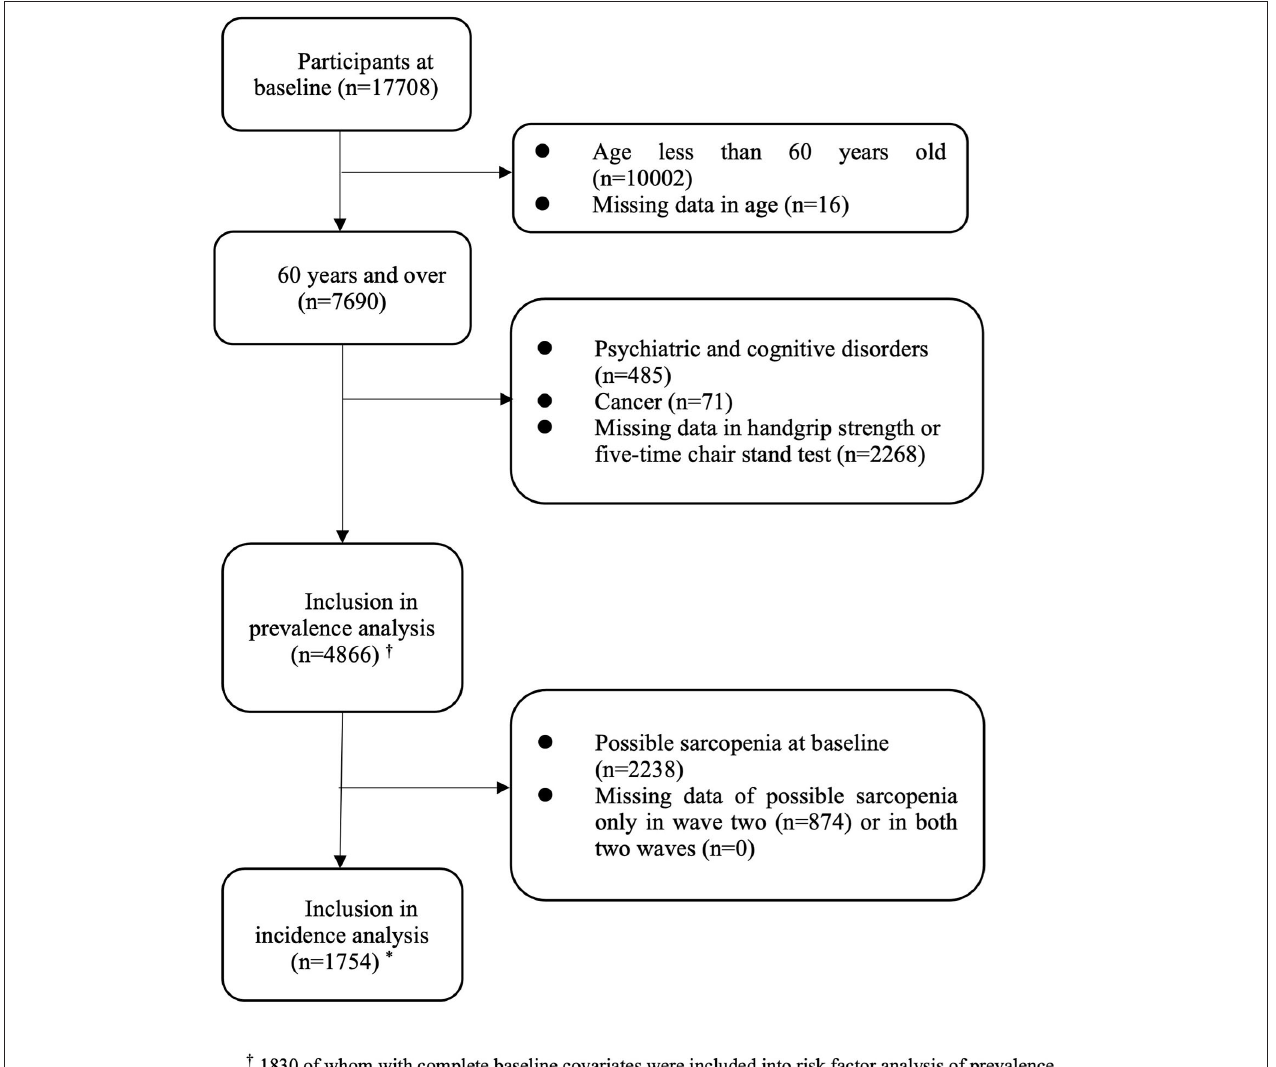
FIGURE 1 | Flowchart of participants